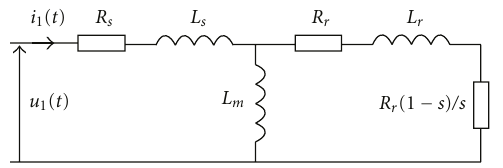
Figure 12: Electric model of an asynchronous motor.